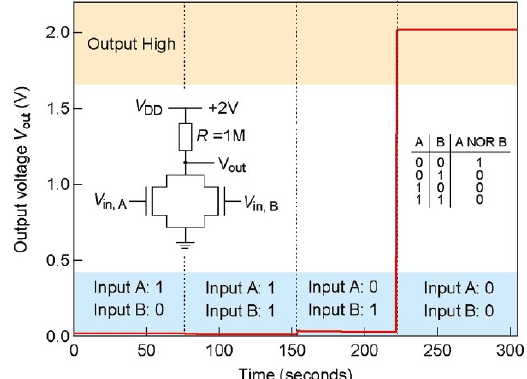
Figure 19. Demonstration of an NOR ‐ gate logic circuit based on monolayer MoS 2 transistors. The Figure 19. Demonstration of an NOR-gate logic circuit based on monolayer MoS 2 transistors. The output voltage V out is shown for four different combinations of input states (1,0), (1,1), (0,1), and (0,0). output voltage V out is shown for four different combinations of input states (1,0), (1,1), (0,1), and (0,0). The output is in the high state only if both inputs are in the low state. Left inset: The circuit is formed The output is in the high state only if both inputs are in the low state. Left inset: The circuit is formed by connecting two monolayer MoS 2 transistors in parallel and using an external 1 M Ω resistor as a by connecting two monolayer MoS 2 transistors in parallel and using an external 1 M Ω resistor as a load. Reproduced with permission from [97], American Chemical Society, 2011. load. Reproduced with permission from [97], American Chemical Society,